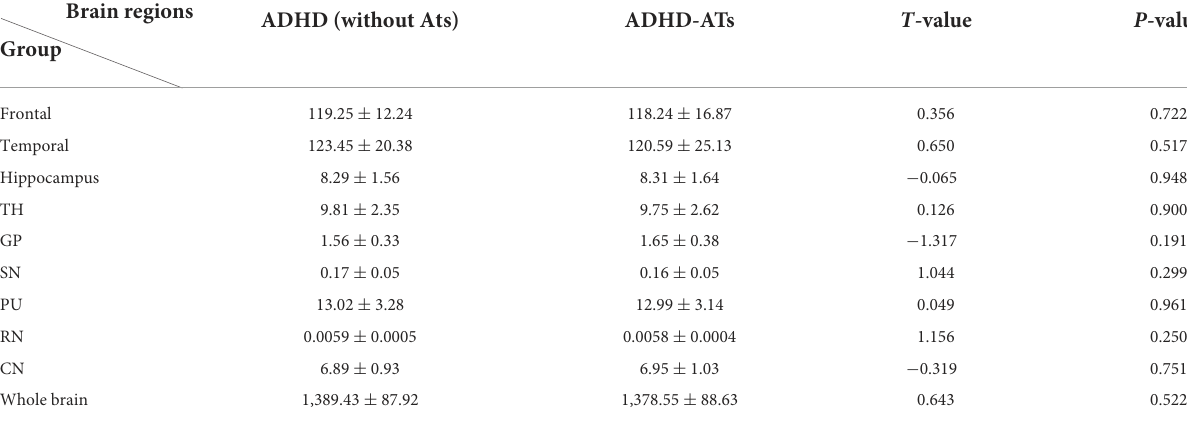
TABLE 3 Volume values of brain regions in children [ ¯ x ± s, volume (cm 3 )].